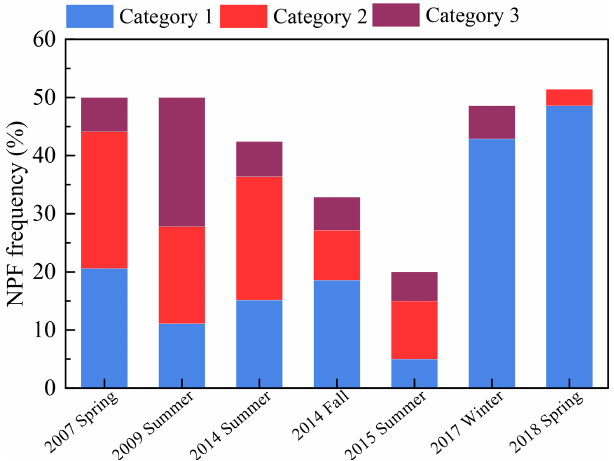
Figure 2. Occurrence frequencies of NPF events in different cate- gories at Mt. Tai during the seven observation